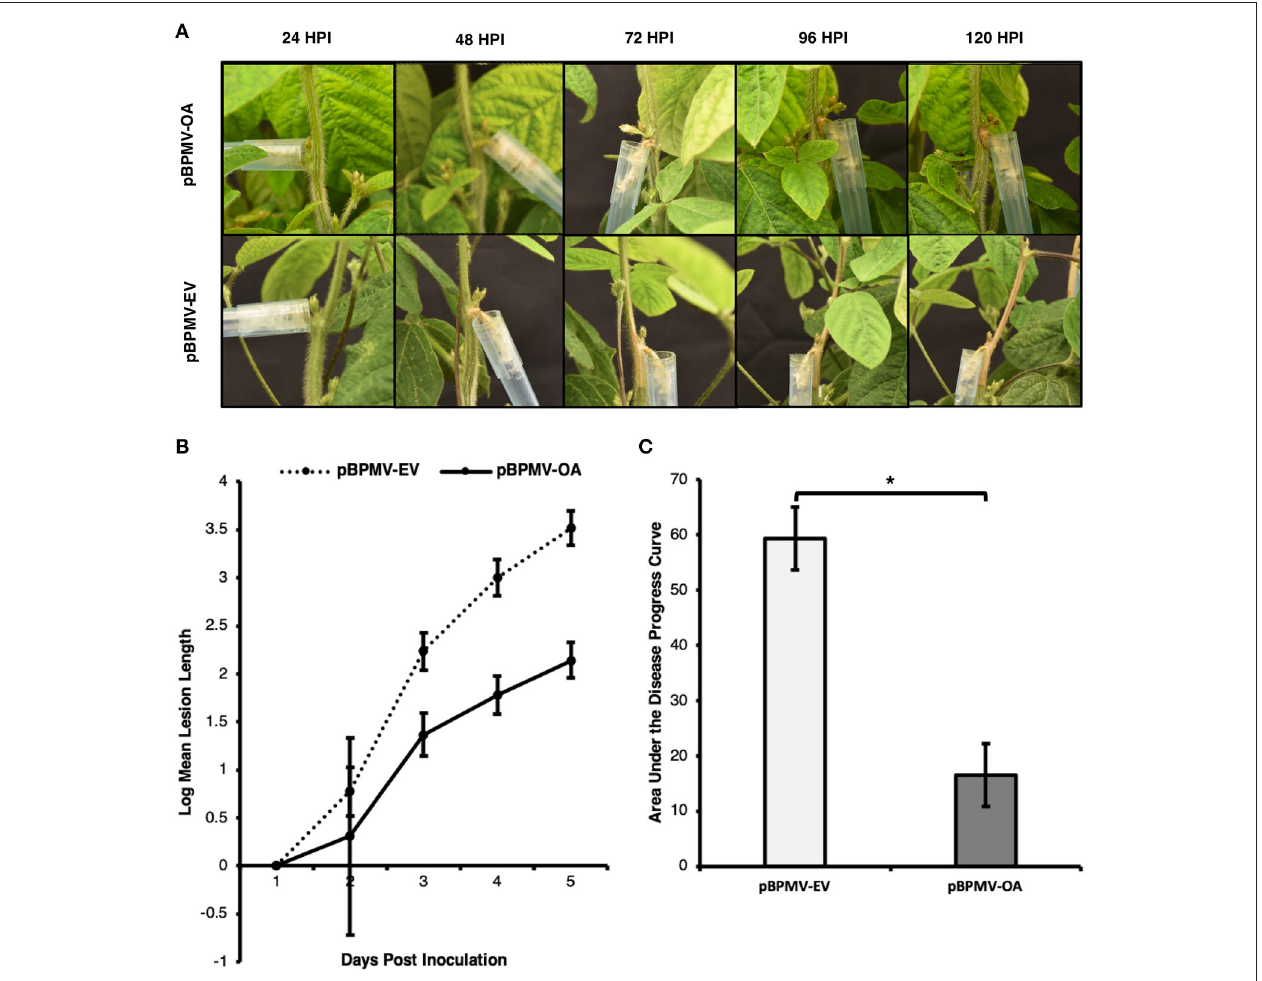
FIGURE 5 | Pathogen aggressiveness was reduced in virus induced gene silencing (VIGS) assays. Plants containing VIGS silencing constructs (pBPMV-OA) and empty vectors (pBPMV-EV) were challenged with S. sclerotiorum strain 1980, using a cut petiole technique. Lesions were measured 1–5 days post inoculation (DPI). Data are the result of five biological replicates and three experimental repetitions. (A) Lesion development was delayed, and lesions were smaller in plants containing pBPMV-OA, while plants containing pBPMV-EV often showed girdling lesions at 96h post inoculation (HPI). (B) Lesion size was reduced after two DPI, with an overall reduced lesion size (* p < 0.01). (C) The overall area under the disease progress curve was lower in plants containing pBPMV-OA (* p <